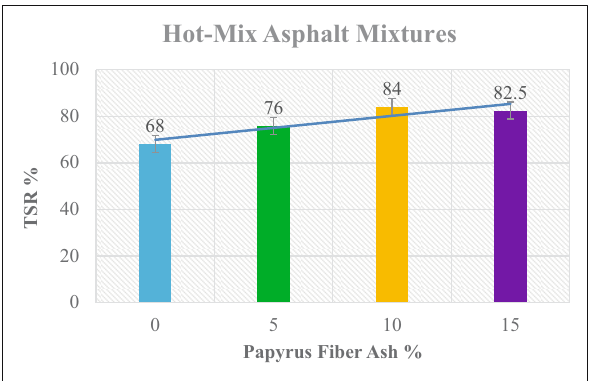
Figure 6: Graph represents the results of the TSR test.